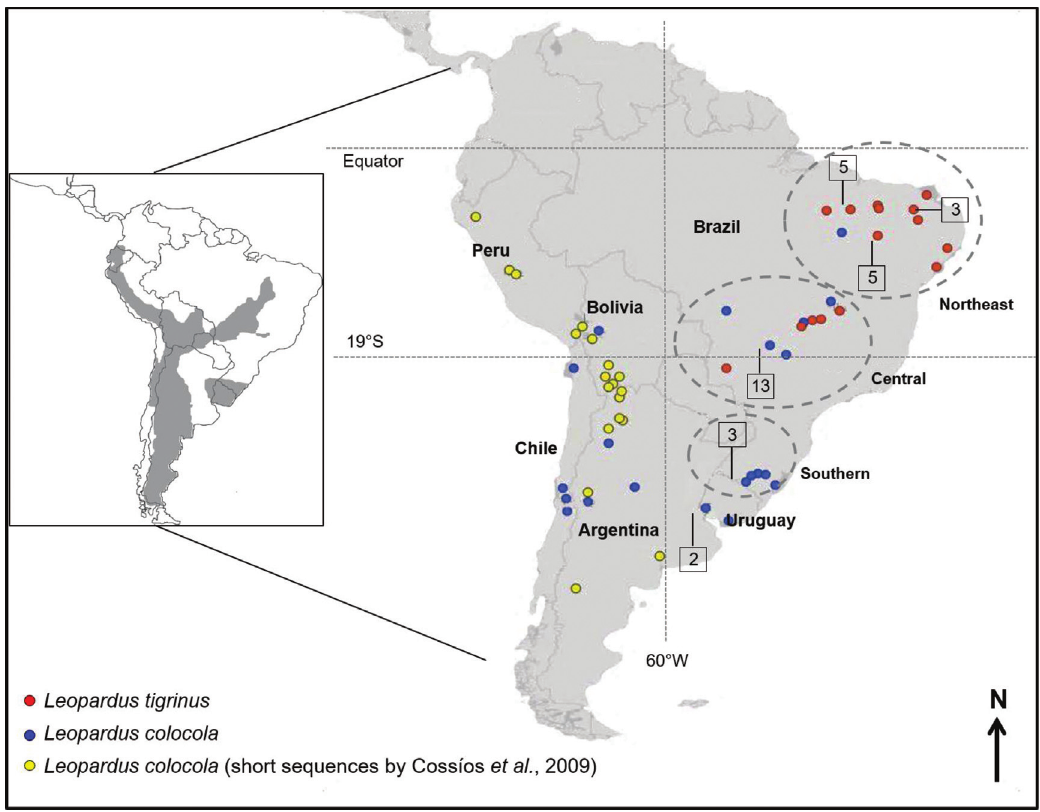
Figure1 -Geographicdistributionof Leoparduscolocola and L.tigrinus samplesanalyzedinthisstudy.DottedcirclesindicatetheBrazilianregionscon- sidered in the analyses. The numbers in squares indicate the number of samples belonging to the same geographic region. The blue and red circles repre- sent samples with mitochondrial sequences generated by this study, while yellow circles represent the geographic origin of haplotypes reported by Cossíos et al. (2009). The inset map on the left shows the geographic distribution of L. colocola (dark grey) [modified from the IUCN (2011) IUCN Red List of Threatened Species ,